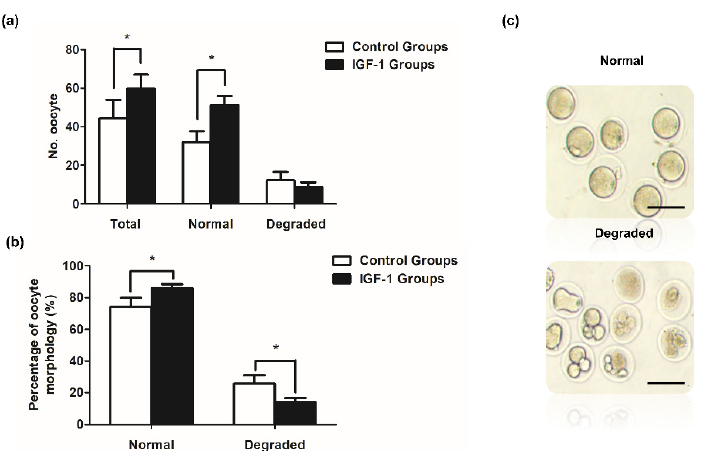
Figure 7. Ovulated oocytes in vivo in mice treated with IGF-1 ( n = 30) or saline control ( n = 30). ( a ) The in vivo number of ovulation oocytes, normal oocytes, and degraded oocytes of mice in IGF-1 treated group or control group; ( b ) Rates of normal oocytes and degraded oocytes of mice in vivo in the IGF-1 treated group or control group; and ( c ) The morphology of normal oocytes and de- graded oocytes. Scale bar: 100 µm. * p < 0.05 compared to control group.